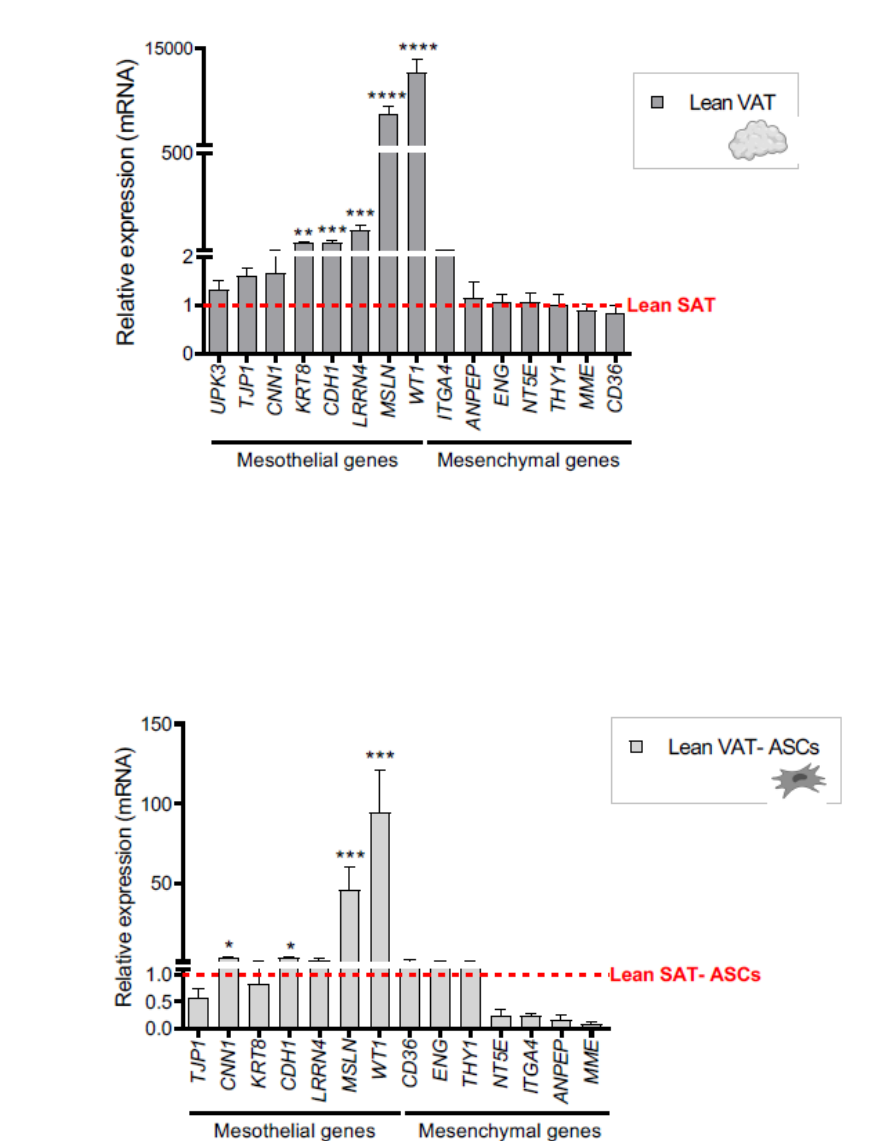
Figure 1. Mesothelial markers are elevated in lean VAT and in VAT-derived ASCs. qPCR analysis of mesothelial and mesenchymal marker expression in ( A ) Lean VAT versus lean SAT samples (VAT n = 10; SAT n = 12) and ( B ) VAT-derived ASCs versus SAT-derived ASCs (VAT-ASCs n = 8, except n = 14 for LRRN4 , MSLN , KRT8 , CDH1 , WT1 , CDH2 , and CA2 ; SAT-ASCs n = 8). Mean lean SAT values were normalized to 1, and are represented as a red dotted line. n represents biologically independent samples. Abbreviations: ANPEP , alanyl aminopeptidase; ASCs, adipose-derived stem cells; CNN1 , calponin 1; CDH1 , cadherin 1; ENG , endoglin; ITGA4 , integrin subunit alpha 4; KRT8 , keratin 8; LRRN4 , leucine rich repeat neuronal 4; MME , membrane metalloendopeptidase; MSLN , mesothelin; NT5E , 5’-nucleotidase ecto; SAT, subcutaneous adipose tissue; TJP1 , tight junction protein 1; UPK3 , uroplakin 3A; VAT, visceral adipose tissue; WT1 , Wilms tumor protein. * p < 0.05; ** p < 0.01; *** p < 0.001; **** p < 0.0001 (Mann-Whitney U test).